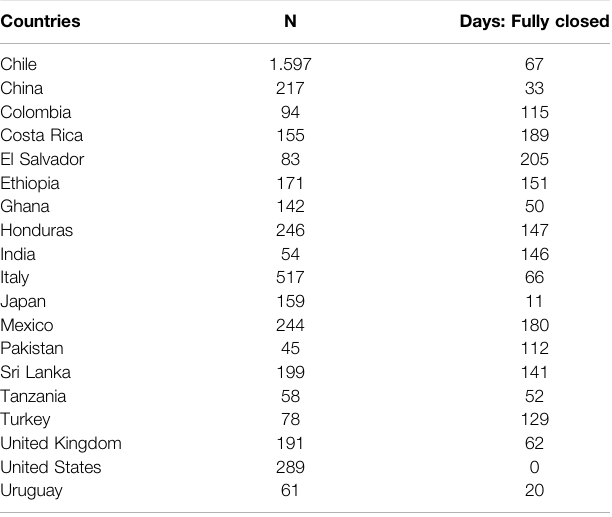
TABLE 1 | Number of observations and days the school was fully closed per